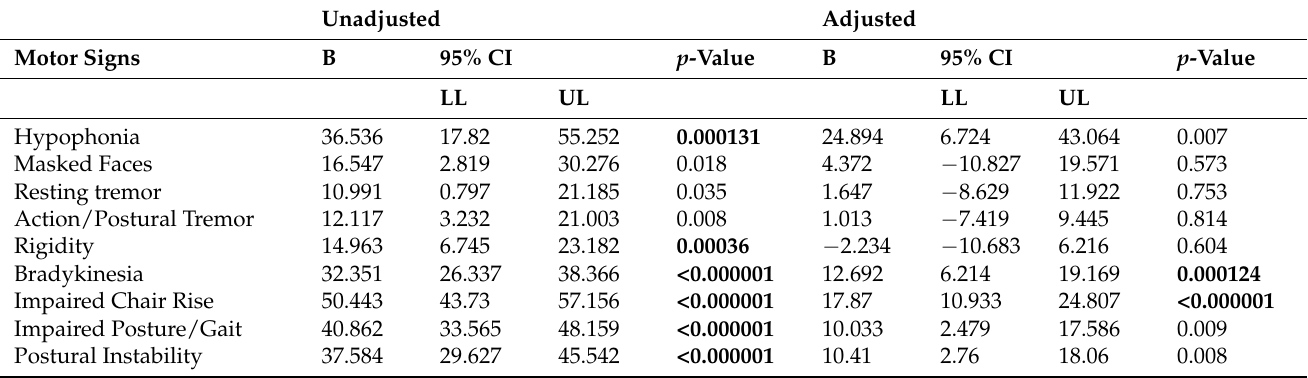
Table 7. Linear regression analysis for association between motor signs and executive